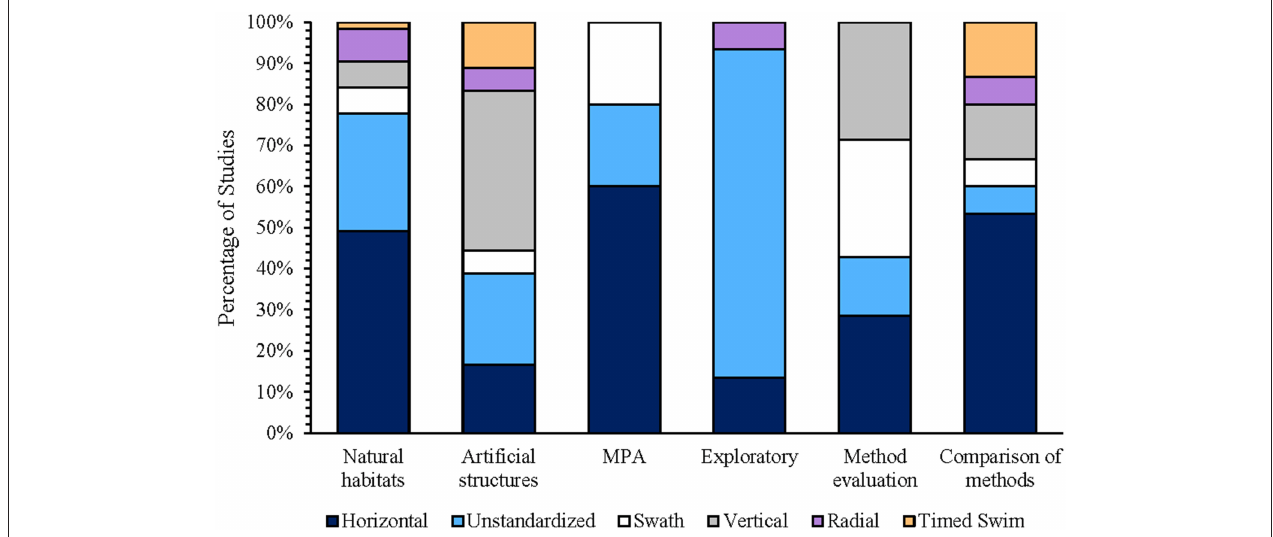
FIGURE 6 | The percentage of studies using horizontal transects (standardized strip/line transects), exploratory transects (unstandardized transects used to make initial baseline inventories of species and community structure), swath transects (strip transects connected to form a grid-like pattern), vertical transects (mobile point count, continuous roving transect, depth-interval transect, vertical strip transect), radial transects (strip transects radiating from a central point), and timed transects (rapid visual count, timed swim, timed stationary counts, and modified timed swim with timed stationary counts) in surveys in natural habitats ( n = 62 studies), studies on artificial structures ( n = 19 studies), surveys in marine protected areas ( n = 5 studies), exploratory surveys ( n = 15 studies), surveys evaluating the effectiveness of ROV -based san1pling strategies ( n = 7 studies), and surveys comparing ROVs against other surveying methods ( n = 15